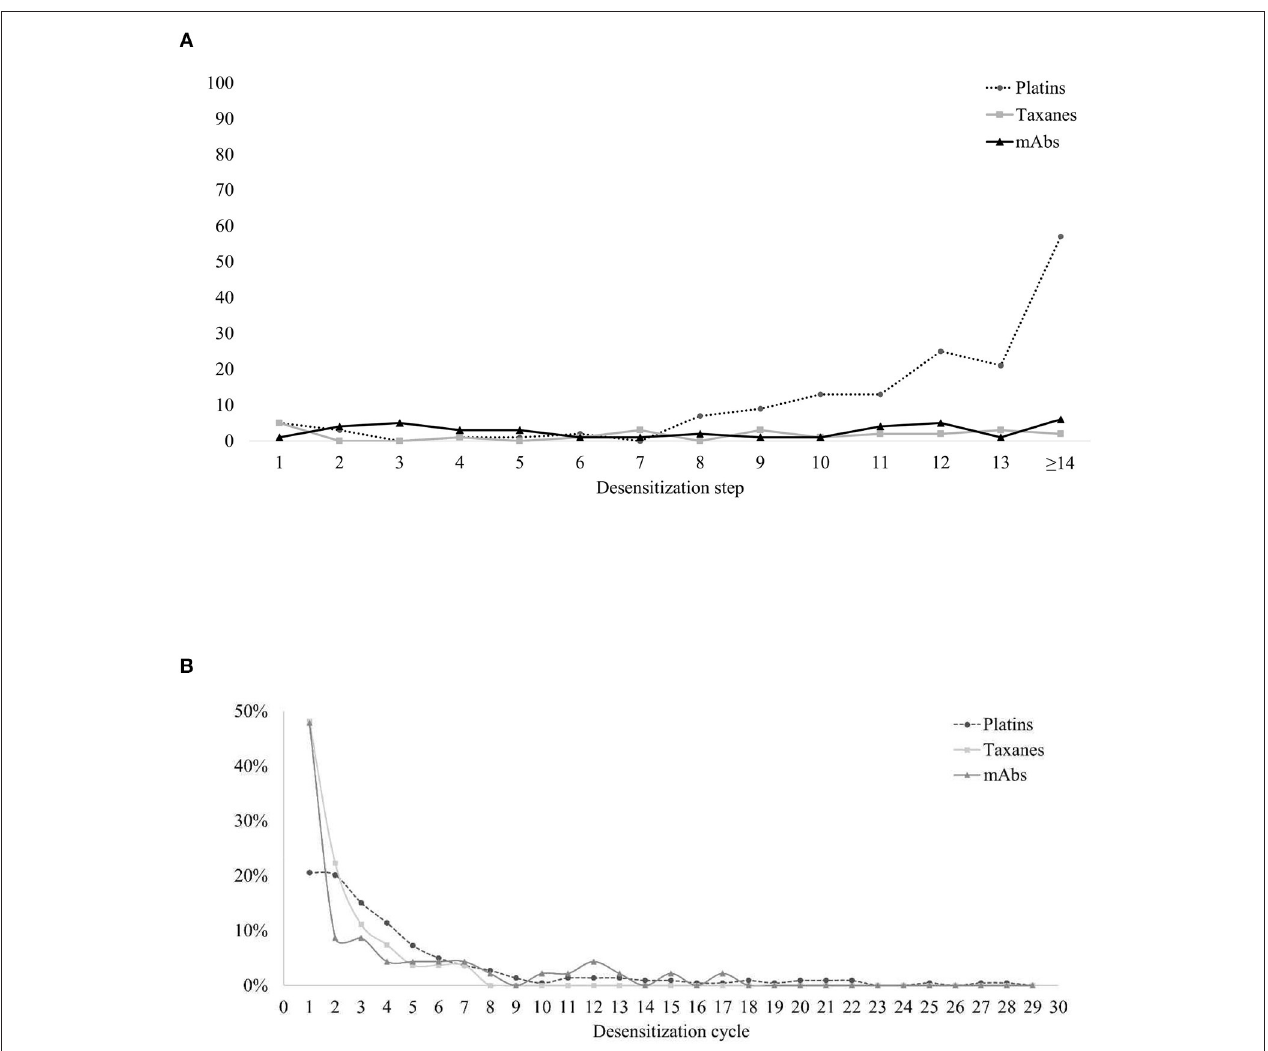
FIGURE 4 | Characteristics of the occurrence of BTRs. (A) BTRs during desensitization: the steps in which BTRs occurred. (B) BTRs along the clinical course: the cycles of desensitization in which BTRs occurred. BTR, breakthrough reactions; mAbs, monoclonal